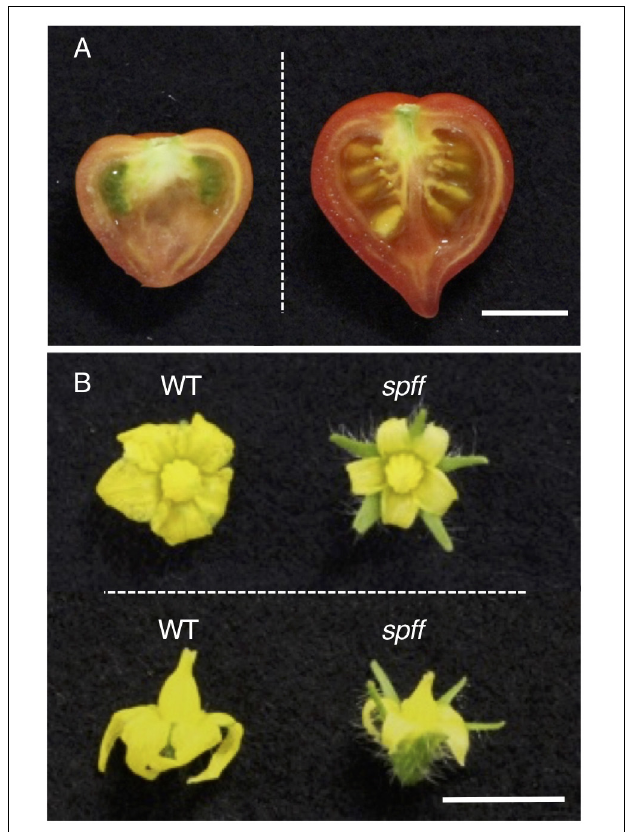
FIGURE 1 | Parthenocarpic fruit and small flower production in spff mutant cultivar Micro-Tom. (A) Representative fruit of the spff mutant. Spontaneously obtained parthenocarpic fruit (left) and seeded fruit from manual pollination of the flower with WT pollen (right) are shown. (B) Comparison of WT and spff flowers at anthesis stage. Bars are 1